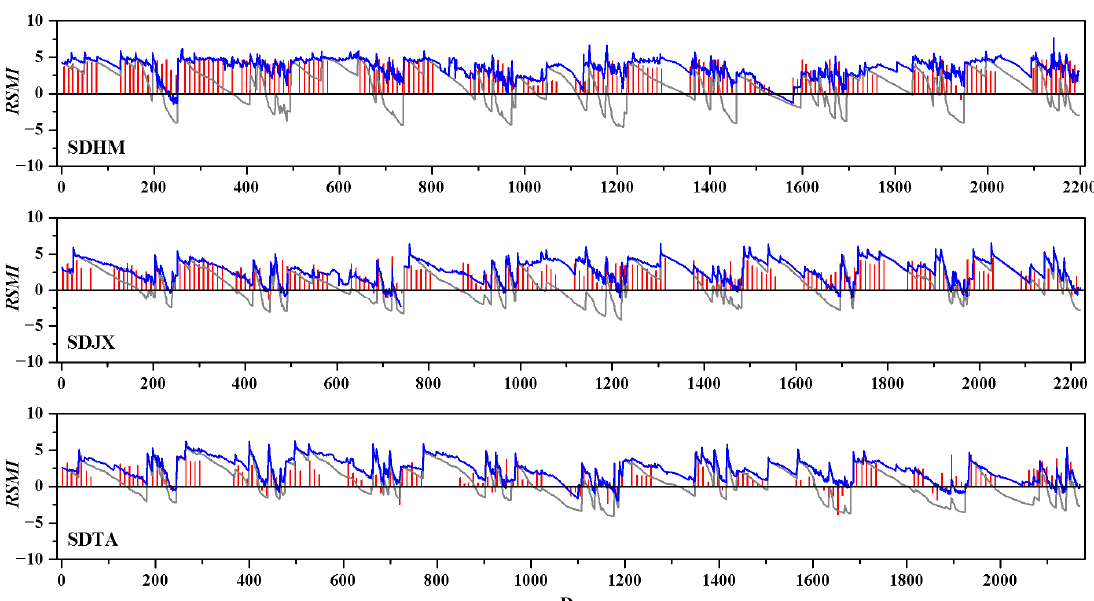
Figure 10. RSMI time series calculated from the observed, simulated and assimilated soil moisture for nine winter wheat growing seasons at the eight sites.